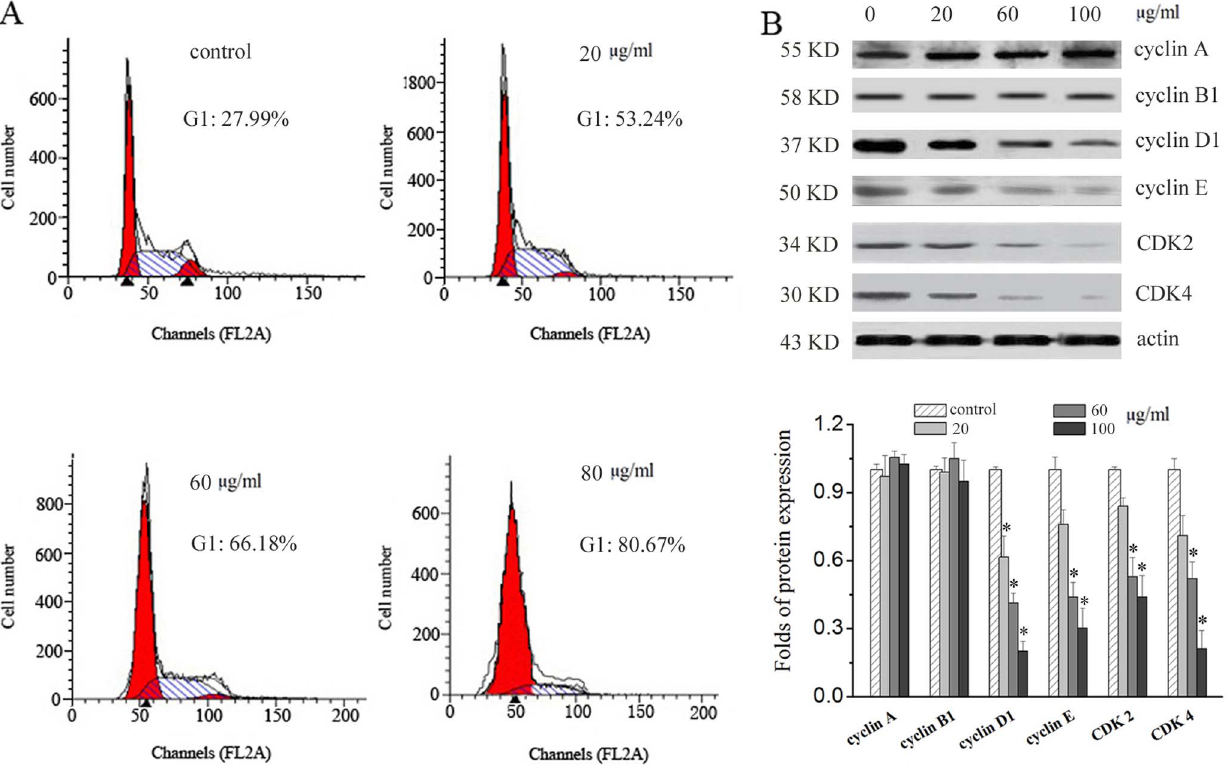
Figure 3. Effects of TCS on Caski cell cycle progress and cell cycle regulatory proteins. Caski cells were treated with indicated doses of TCS for 24 h. Cell numbers at G1 phase increased significantly (A) and expressions of cyclin D1, E and CDK2, 4 significantly decreased (B). Data represent means 6 SD of three independent experiments (* p , 0.05 compared with control).